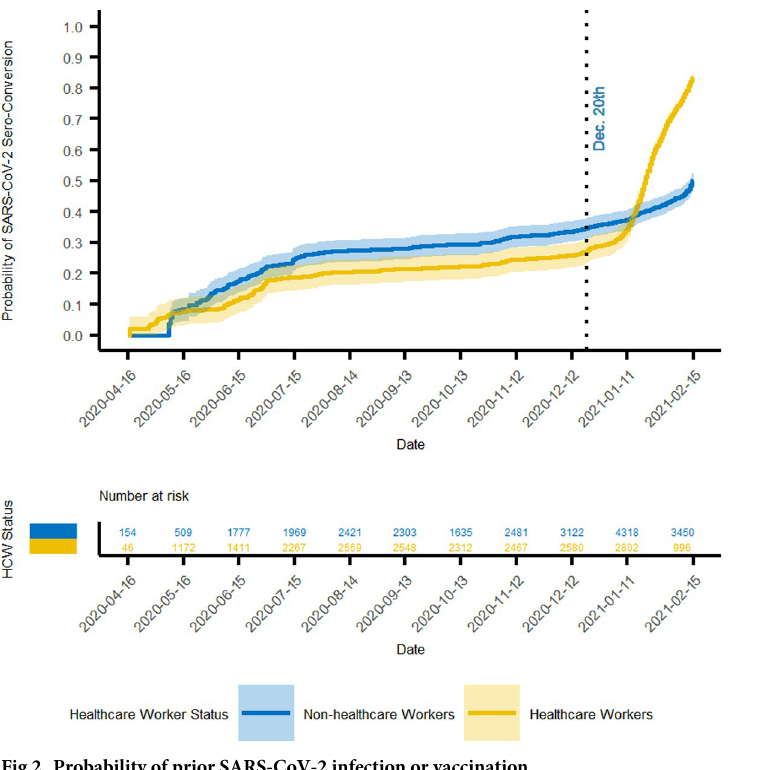
Fig 2. Probability of prior SARS-CoV-2 infection or vaccination.